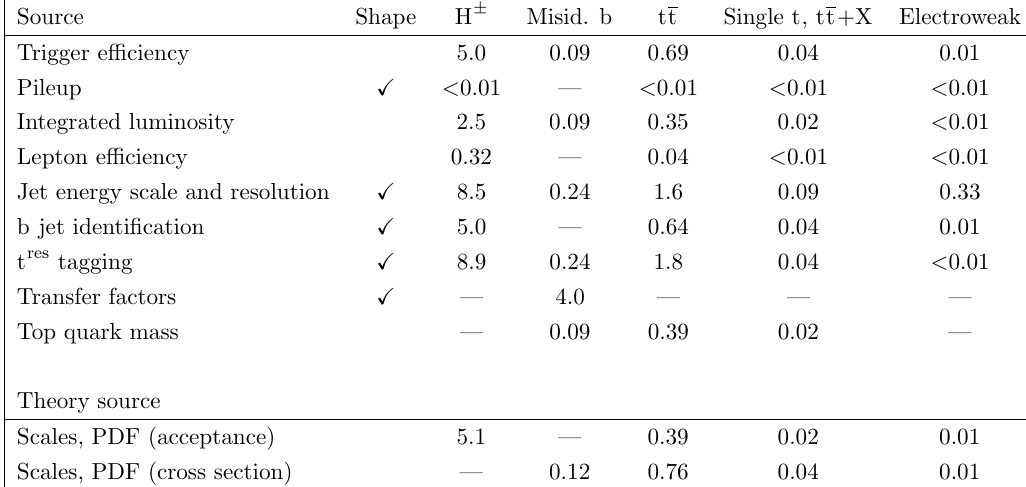
Table 2 . The systematic uncertainties in the backgrounds and the signal for the resolved analysis, evaluated after (cid:12)tting to data. The numbers are given in percentage and describe the e(cid:11)ect of each nuisance parameter on the overall normalization of the signal model or the total background. Nuisance parameters with a check mark also a(cid:11)ect the shape of the H (cid:6) candidate mass spectrum. Sources that do not apply in a given process are marked with dashes. For the H (cid:6) signal, the values for m = 0 : 5 TeV are shown. H (cid:6)